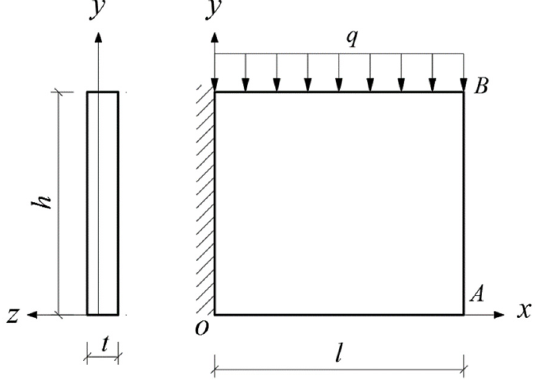
Figure 6. Bimodular rectangular plate with top